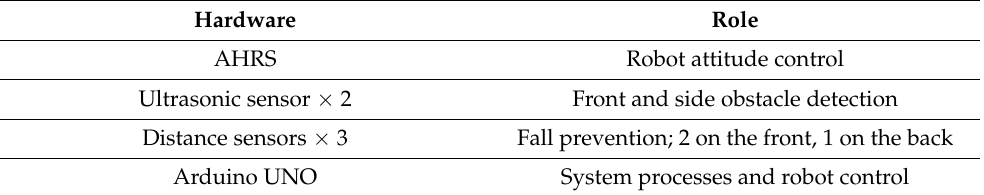
Table 1. Hardware